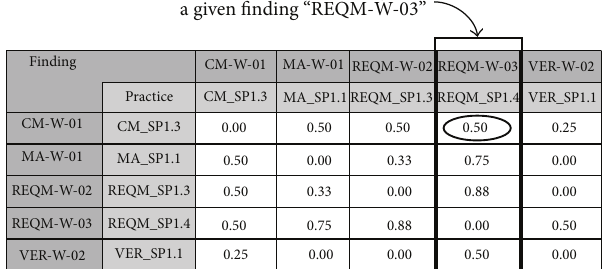
Figure 9: Example of resulting finding correlation.